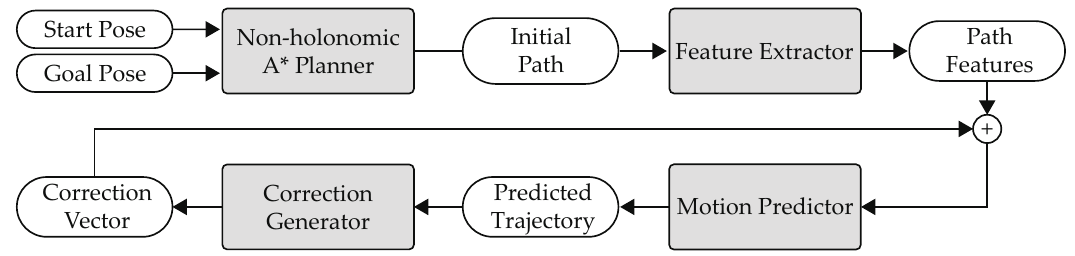
Figure 6. Overview of the trajectory planning